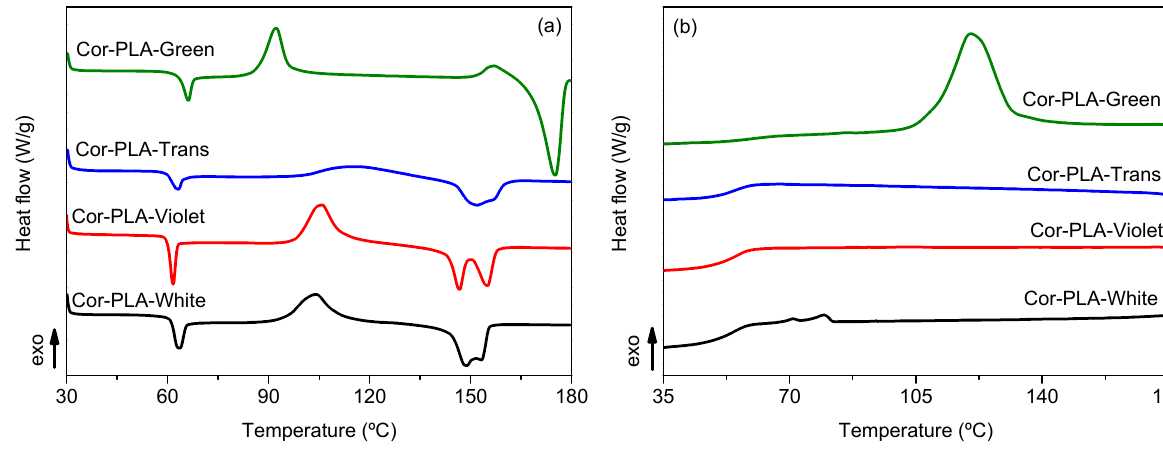
Figure 7. DSC first heating ( a ) and cooling ( b ) scans of the components of the 3D printing waste.